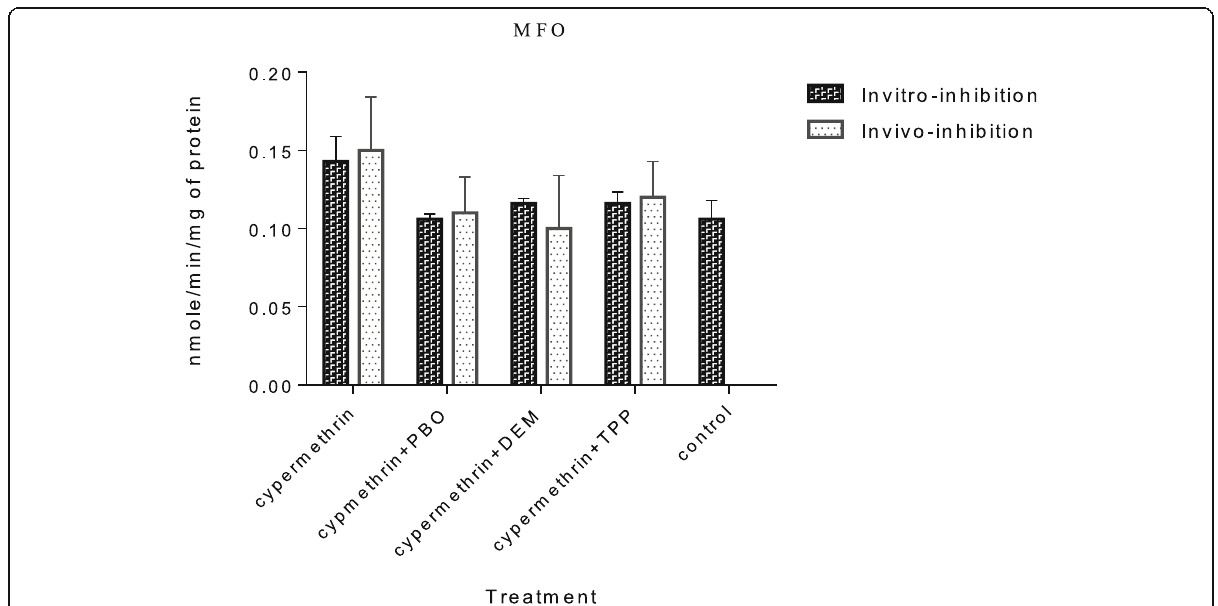
Fig. 3 In vitro and in vivo inhibition of fourth instar larvae Amsacta albistriga mixed-function oxidase activity with and without enzyme inhibitor (PBO, DEM, and TPP)